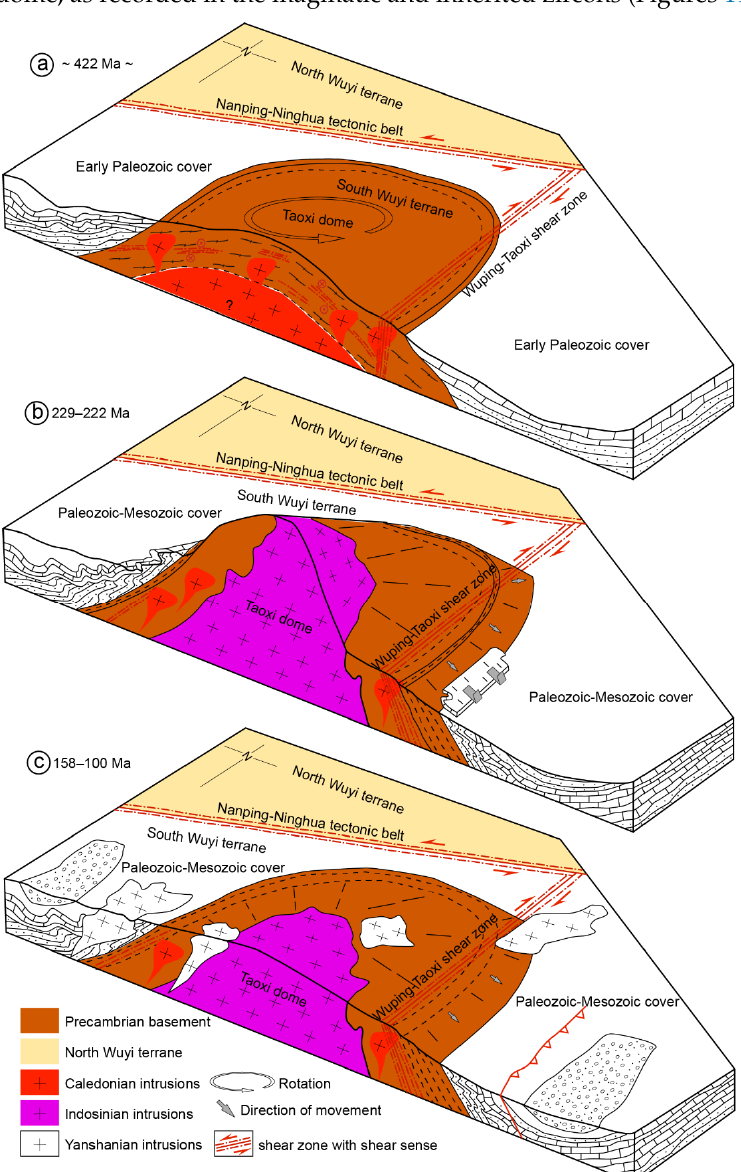
Figure 20. Simplified geological three-dimensional map showing the multi-stage uplift of the Taoxi dome. ( a ) Anticlockwise rotation of the Precambrian basement in the Taoxi dome at about 422 Ma, on account of collision between the North Wuyi terrane and the South Wuyi terrane along the Nanping–Ninghua tectonic belt, giving rise to the development of the Wuping–Taoxi shear zone and widespread deformation in the Precambrian basement. ( b ) Indosinian intrusions widely devel- oped in the core of the Taoxi dome at 229–222 Ma, leading to the uplift of the Taoxi dome. ( c ) Yansha- nian intrusions developed around or in the Taoxi dome at 158–100 Ma, which may have had an effect on the uplift of the Taoxi dome.